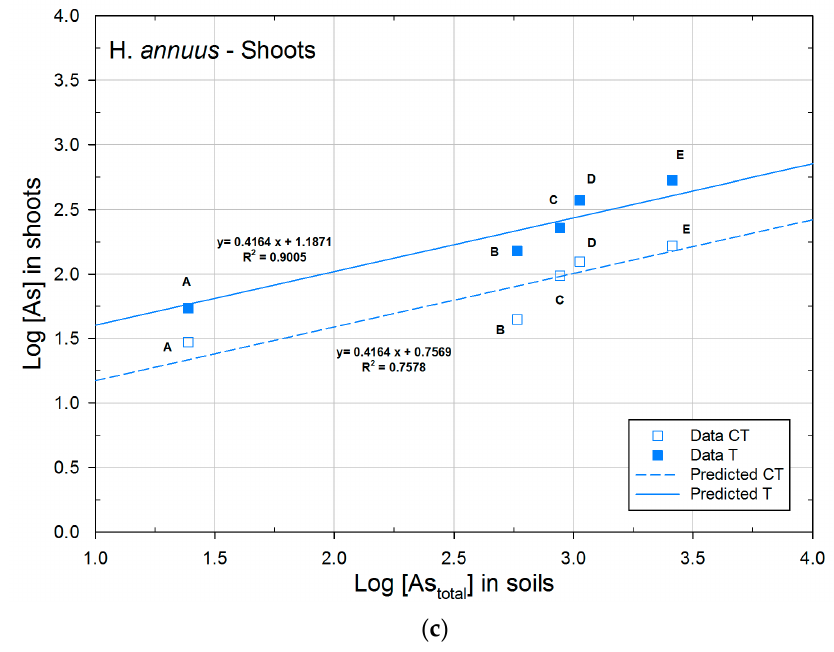
Figure 2. Freundlich-like equation for the shoots uptake of B. juncea ( a ), L. albus ( b ), and H. annuus ( c ) in control (CT) and phosphate treated (T) soils.